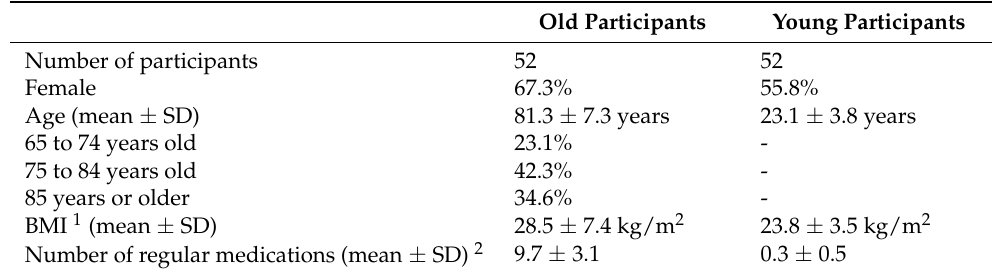
Table 2. Characterization of participants, subdivided in the two age categories: old and young. Old Participants Young Participants Number of participants 52 52